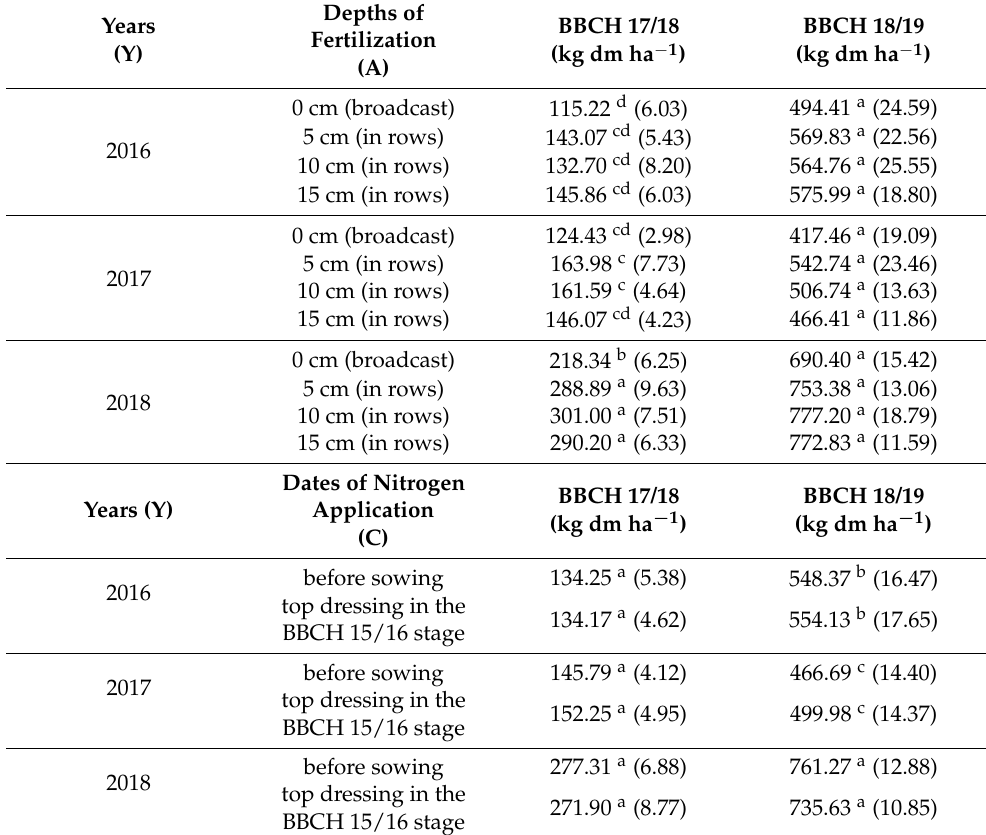
Table 5. Mean values for the combinations years (Y) × A factor and years (Y) × C